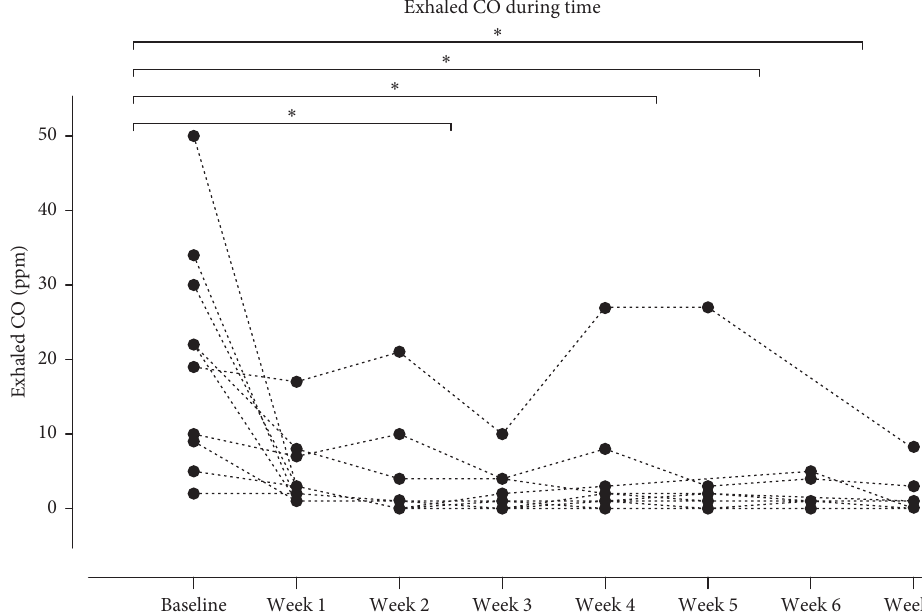
Figure 1: Changes in exhaled CO during the 8-week period of stimulation. There was a statistically significant difference in CO con- centration in different time points: from baseline to week 3 ( p < 0.01), week 5 ( p < 0.01), week 6 ( p < 0.01), and last week 7 ( p < 0.01). CO, carbon monoxide; PPM, parts per million.